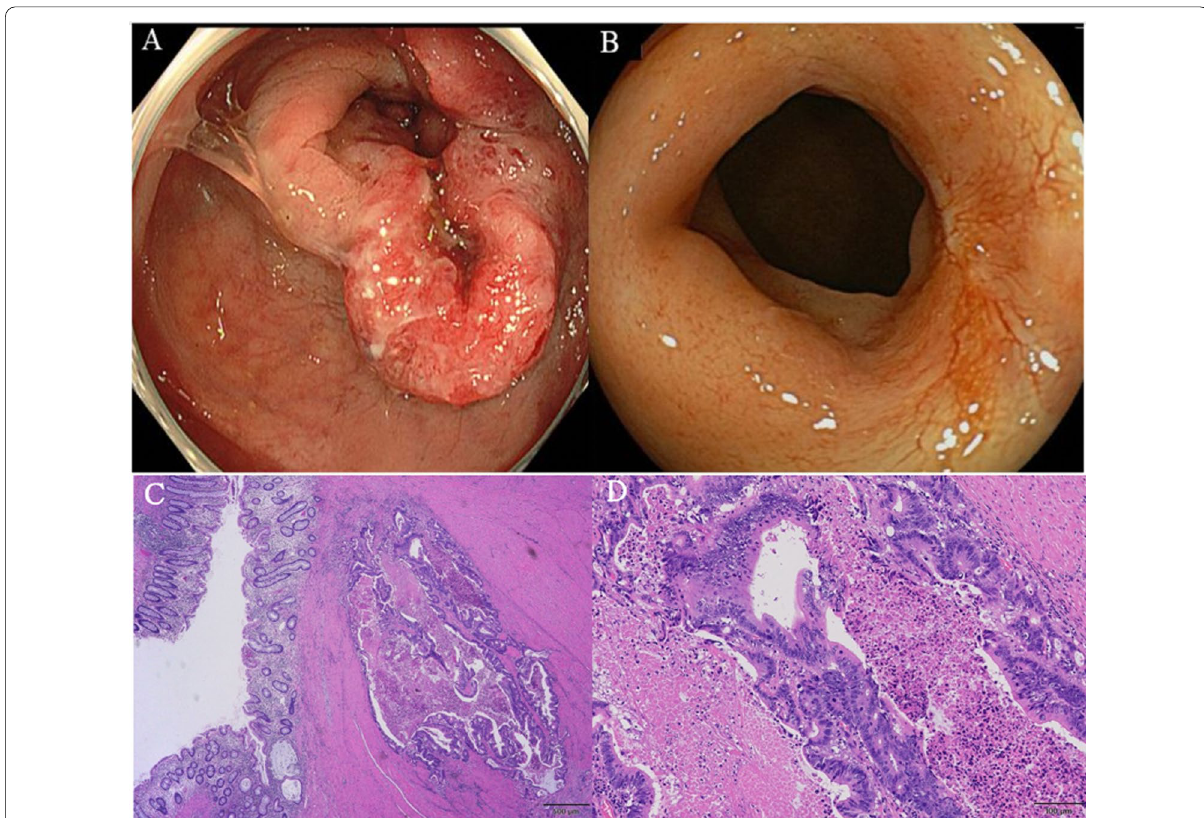
Fig. 1 Preoperative colonoscopy. A Initial colonoscopy shows a rectal tumor below the peritoneal reflection 5 cm from the anal verge, occupying three quarters of the circumference. B Colonoscopy after chemoradiation therapy shows that the tumor responded clinically, and there is no evidence of the previous features, except for a flat white scar and telangiectasias. At the distal end of the tumor, the mucosa is reddish and swollen. Hematoxylin and eosin-stained sections ( C , 20. D , 100.) show a well-differentiated adenocarcinoma with a partially tubular × ×